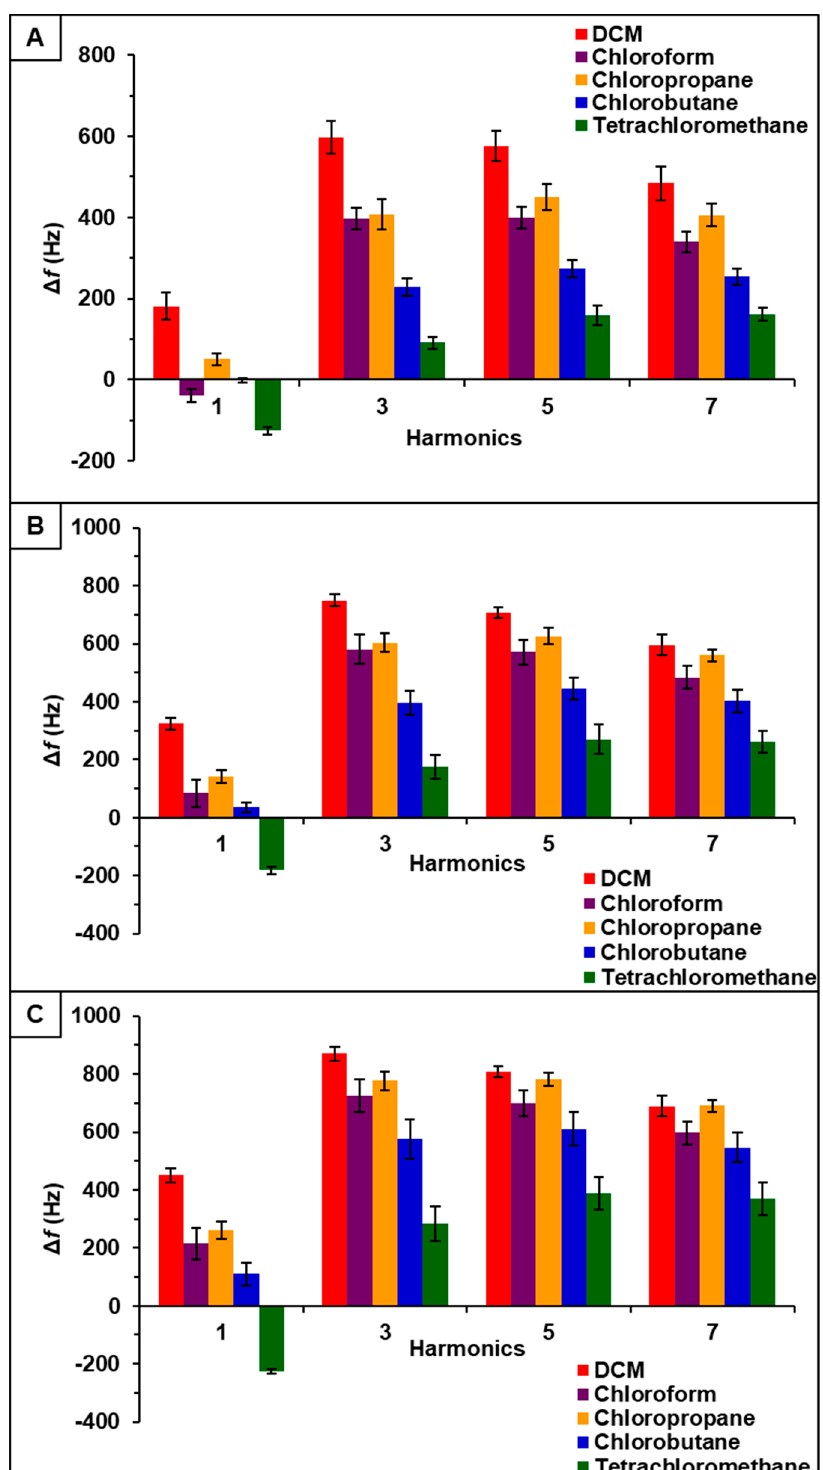
Figure 4. [P 66614 ][BS] ‐ PDMS sensor response to chlorinated VOCs at multiple harmonics at ( A ) 0.2 flow ratio, ( B ) 0.3 flow ratio, and ( C ) 0.4 flow ratio. Error bars represent standard deviation for three replicate measurements.